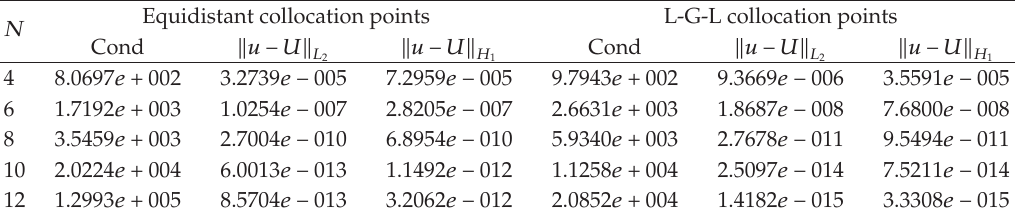
(cid:4) 100, β (cid:4) 10 (cid:6) . 1 2